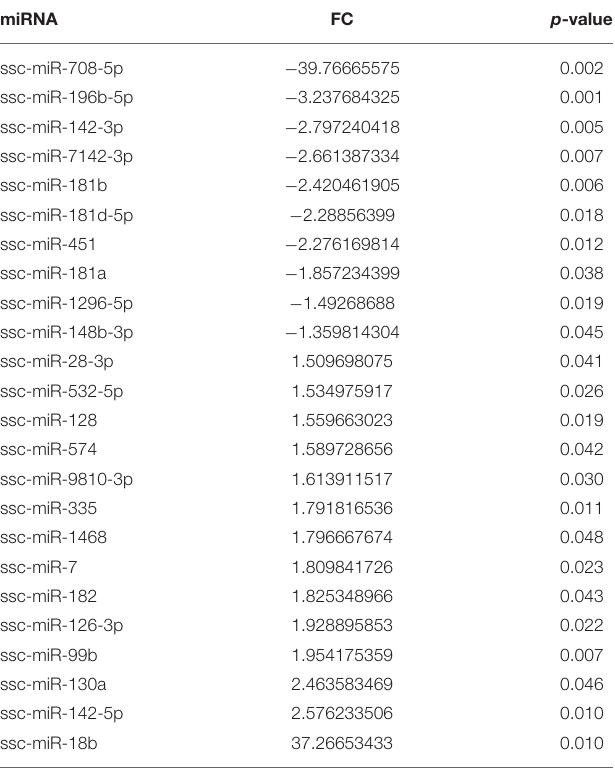
TABLE 2 | MF fed piglets have differential miRNA expression at PND 35 relative to HM fed piglets. miRNA FC p -value